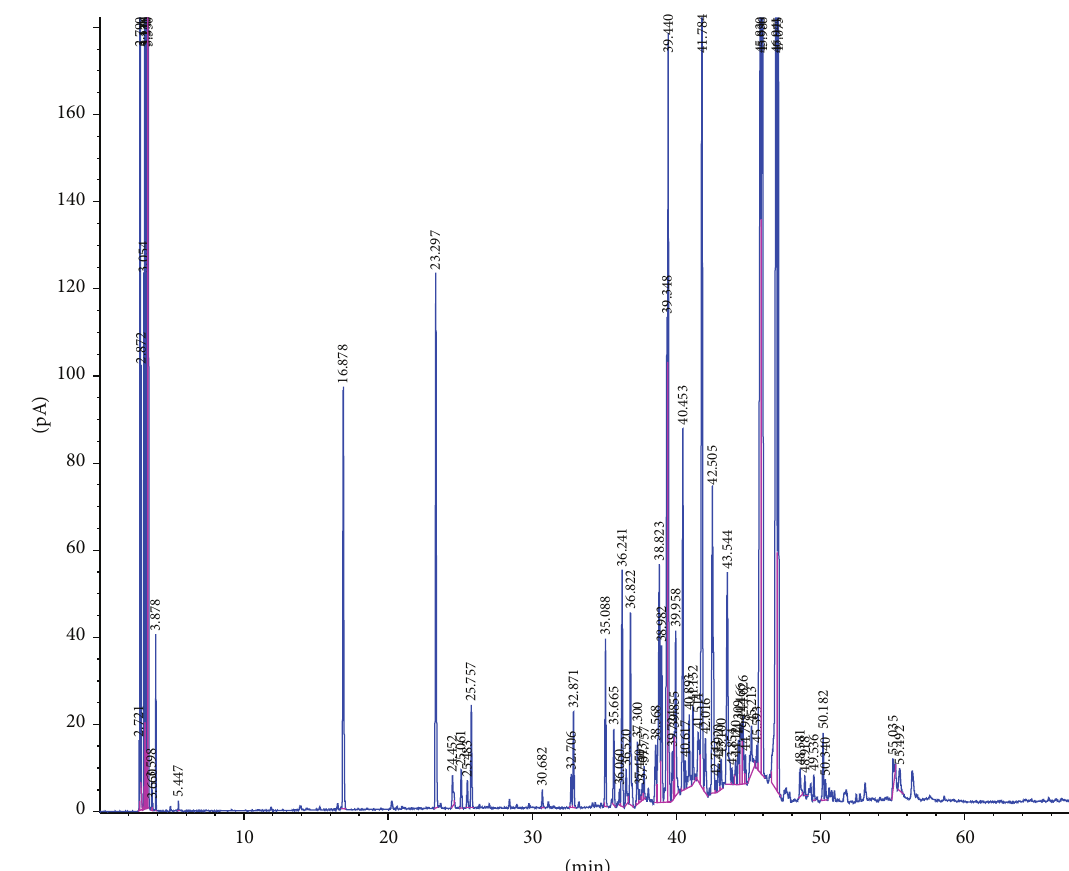
Figure 1: The GC-FID profile of the essential oil of rhizomes of Curcuma purpurascens Bl. ( temu tis